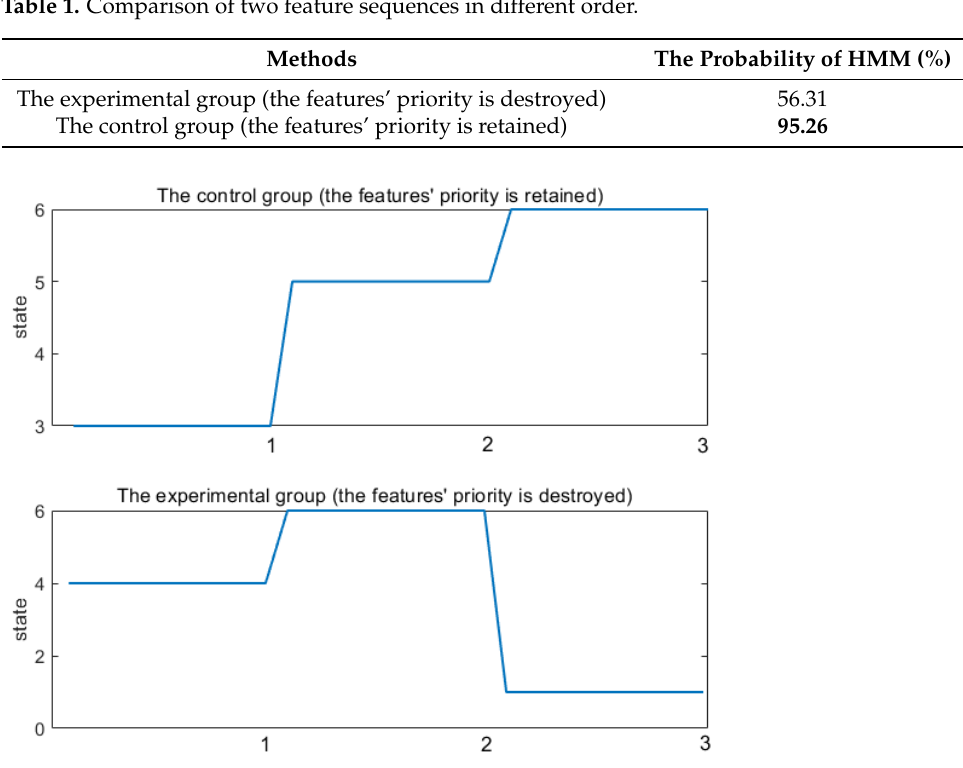
Figure 7. The “hidden state evolution laws” obtained by the HMM according to two different feature